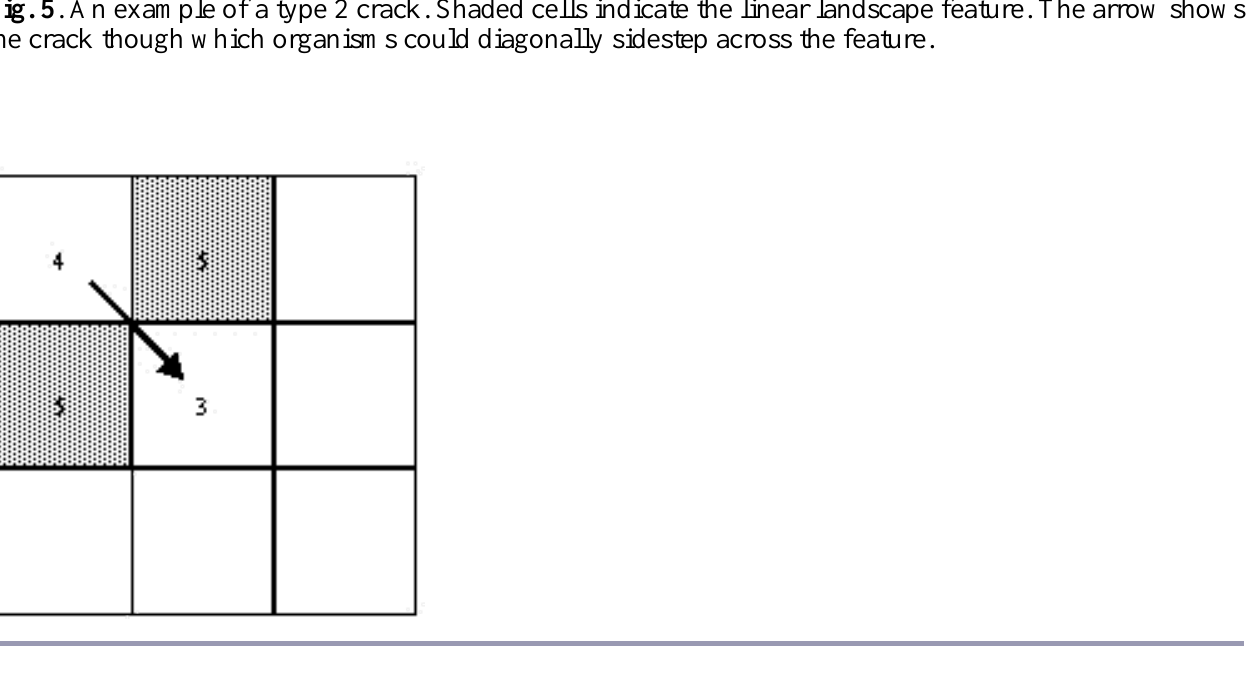
Fig. 5 . An example of a type 2 crack. Shaded cells indicate the linear landscape feature. The arrow shows the crack though which organisms could diagonally sidestep across the